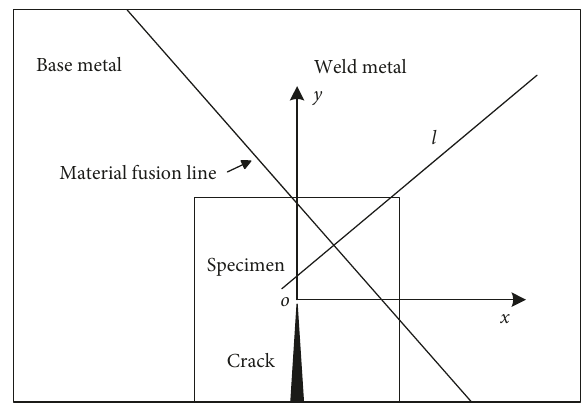
Figure 1: Relationship between the change law of mechanical properties and space